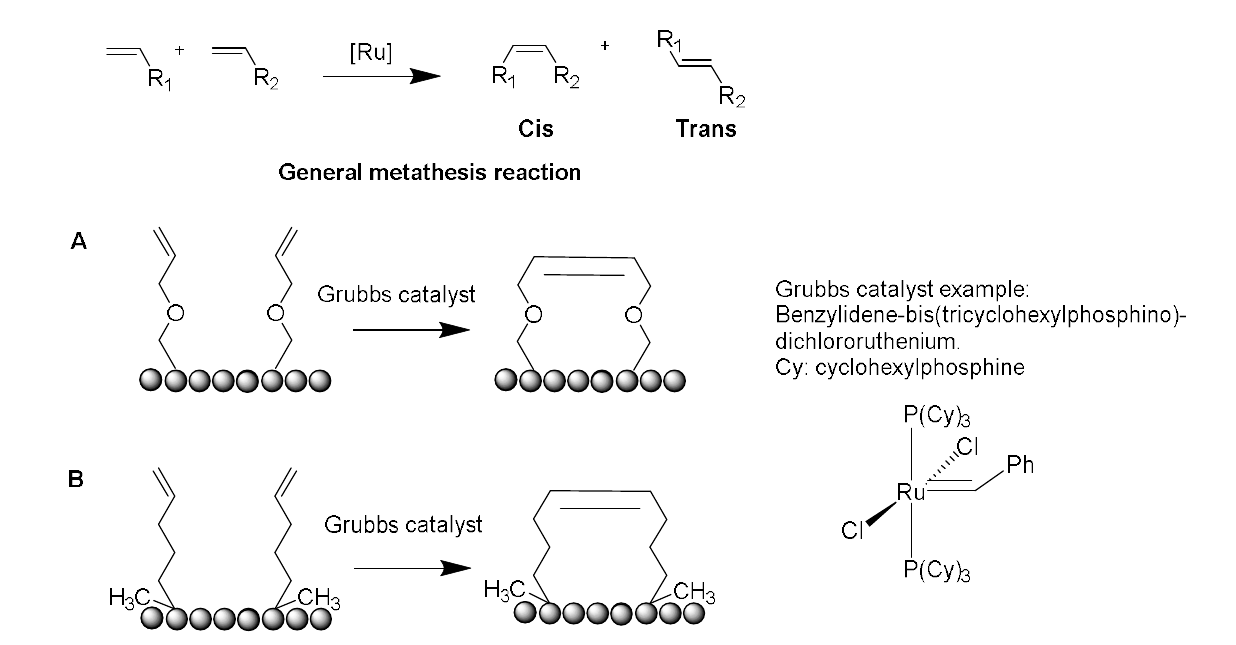
Figure 5. Ruthenium catalyzed olefin metathesis (RCM). ( A ) O -allyl serine residues by Grubbs [59]. ( B ) The α , α -disubstitution, olefin tether by Verdine [60].